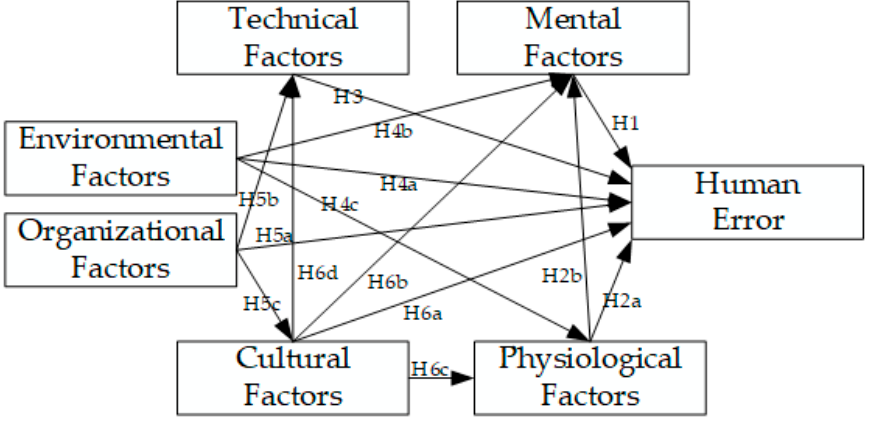
Figure 1. Schematic diagram of the model.